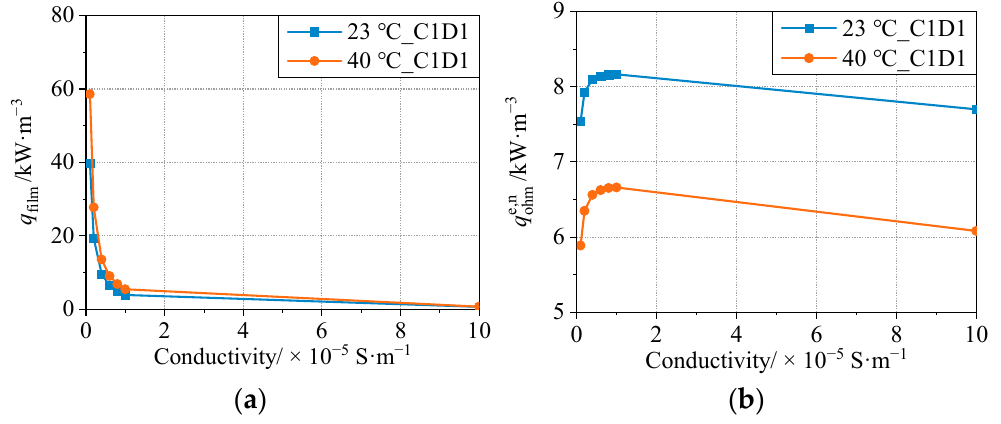
Figure 12. Simulation results of the heat generation rate during the discharge process of the cell after aging when using different SEI ionic conductivities. ( a ) SEI growth heat and ( b ) negative electrolyte ohmic heat.